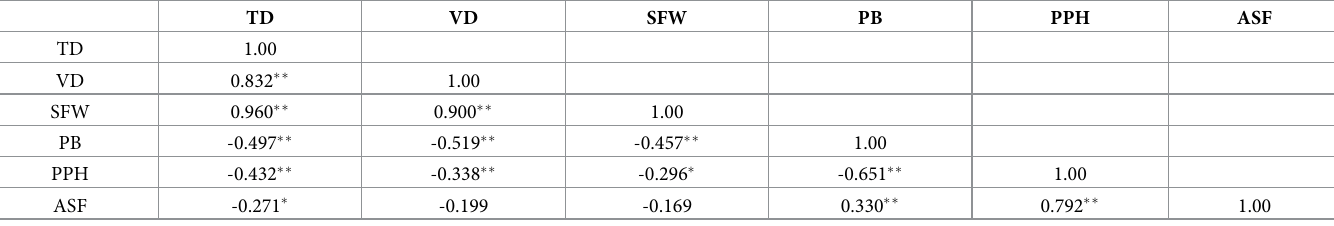
Table 1. Phenotypic correlation coefficients between the traits of hawthorn berries produced by crossing ‘Shandongdamianqiu’ with‘Xinbinruanzi’. TD VD SFW PB